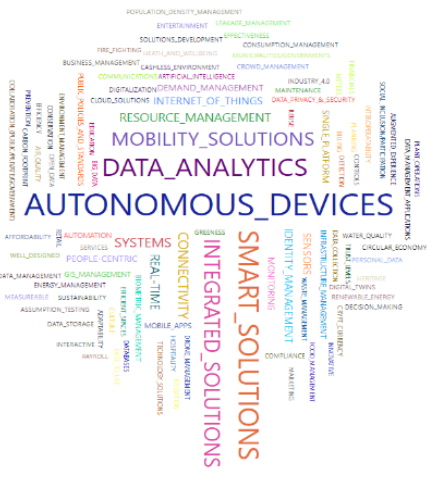
Figure 7. Smart City Solutions